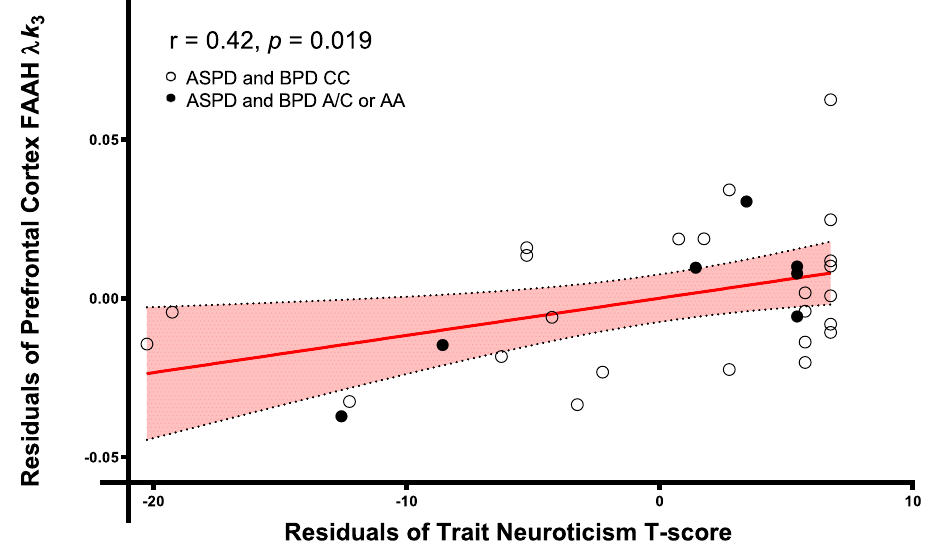
Figure 1. Prefrontal cortex fatty acid amide hydrolase λ k 3 is correlated with trait neuroticism ( T score) controlling for genotype in antisocial and borderline personality disorders.